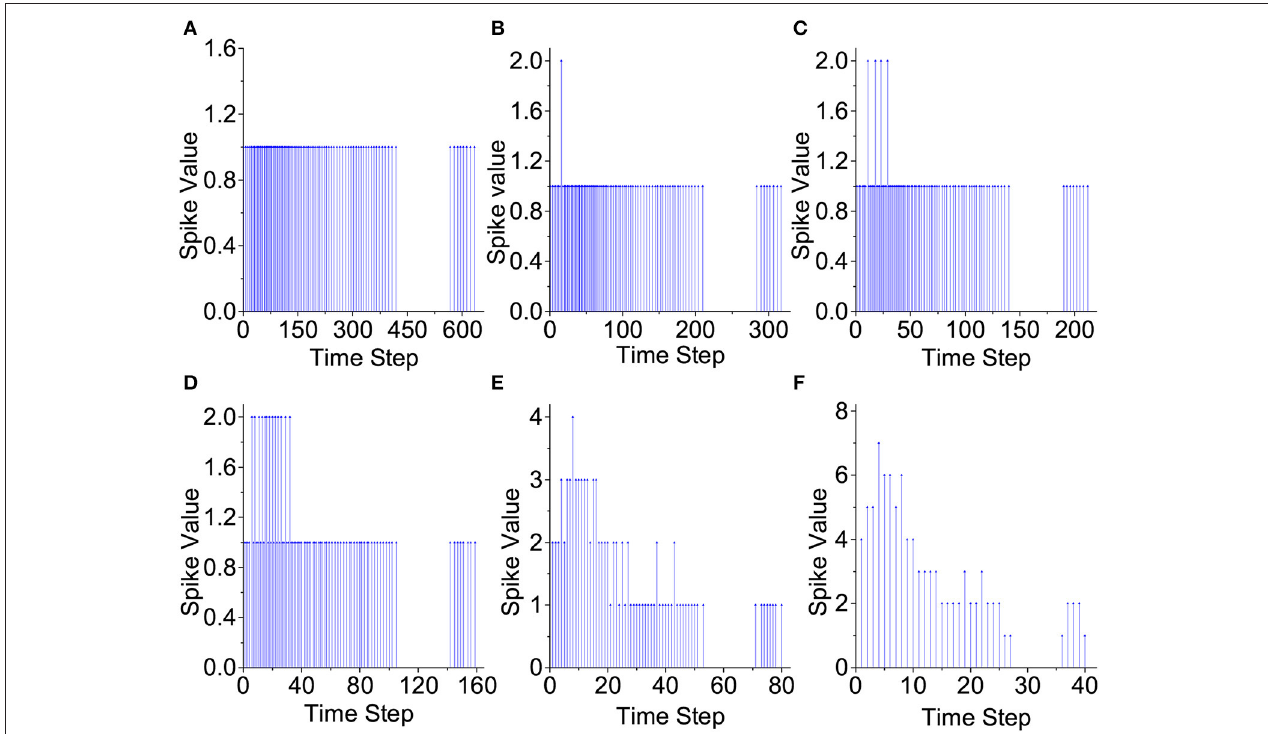
FIGURE 8 | Proposed input compression of a speech example. (A) No compression, (B) 2:1 compression, (C) 3:1 compression, (D) 4:1 compression, (E) 8:1 compression, and (F) 16:1